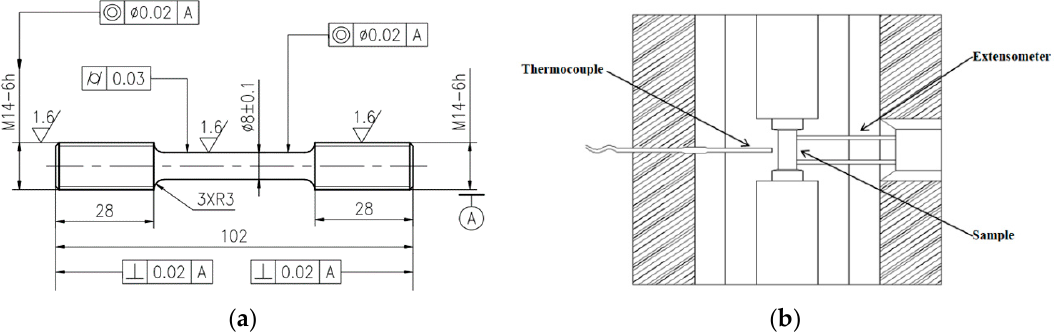
Figure 1. Experimental sample and device, ( a ) shape and dimensions of fatigue test specimens (dimensions in mm), and ( b ) installation of extensometers and thermocouples.